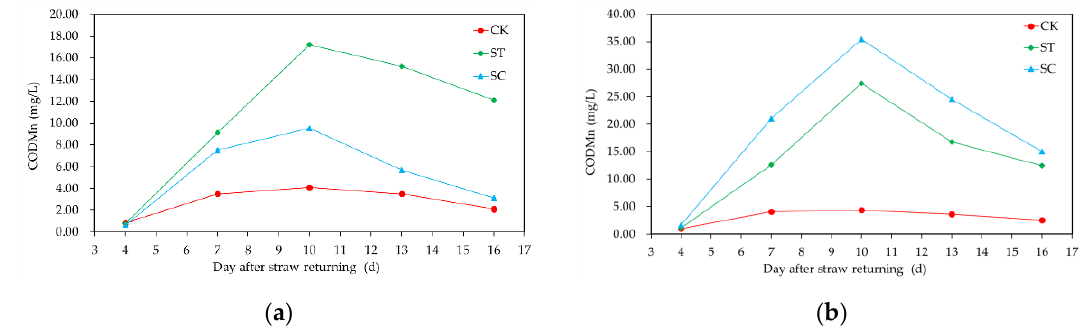
Figure 4. Characteristics of CODMn under flood conditions with different treatments: ( a ) surface water; and ( b ) 0–10 cm soil water.